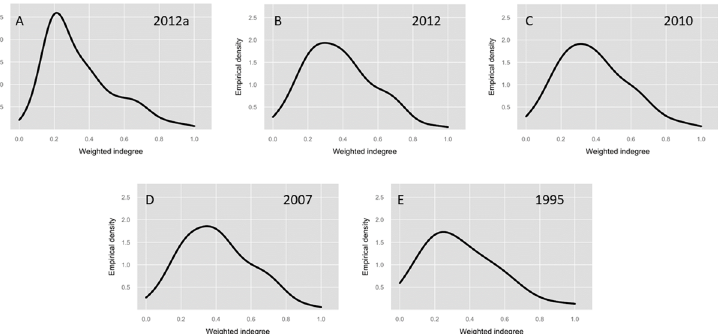
Fig 2. Density first-order weighted indegree input-output matrices1995–2012. (A) Detailedmatrix 2012, 245 economicsectors. (B) Summary matrix 2012, 71 economicsectors. (C) Matrix 2010, 71 economic sectors. (D) Matrix 2007, 71 economicsectors. (E) Matrix 1995, 34